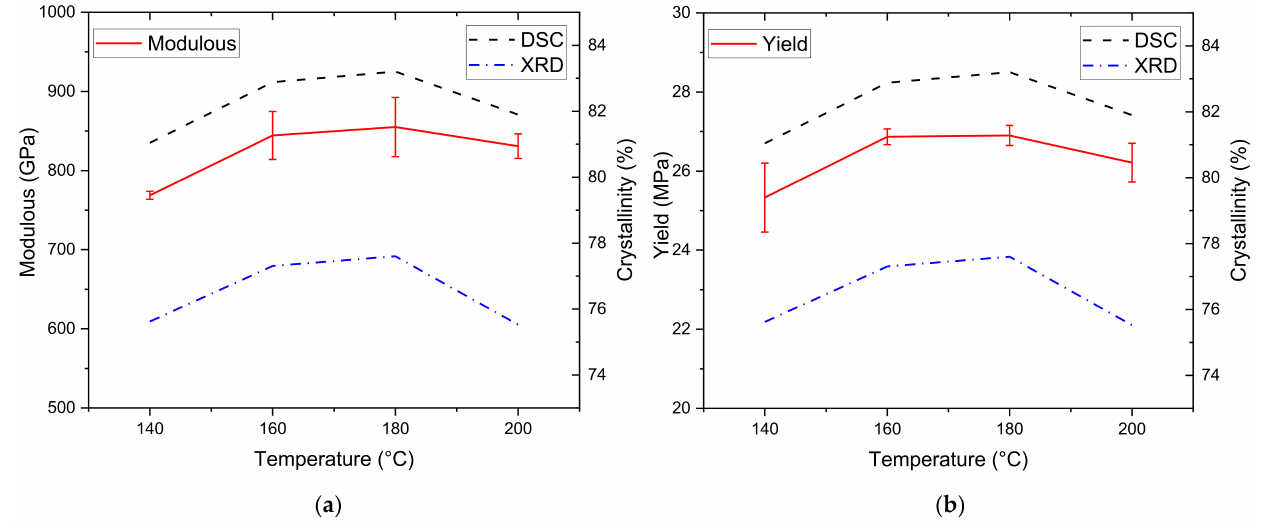
Figure 6. Crystallinity vs. mechanical properties: ( a ) modulus, ( b ) yield